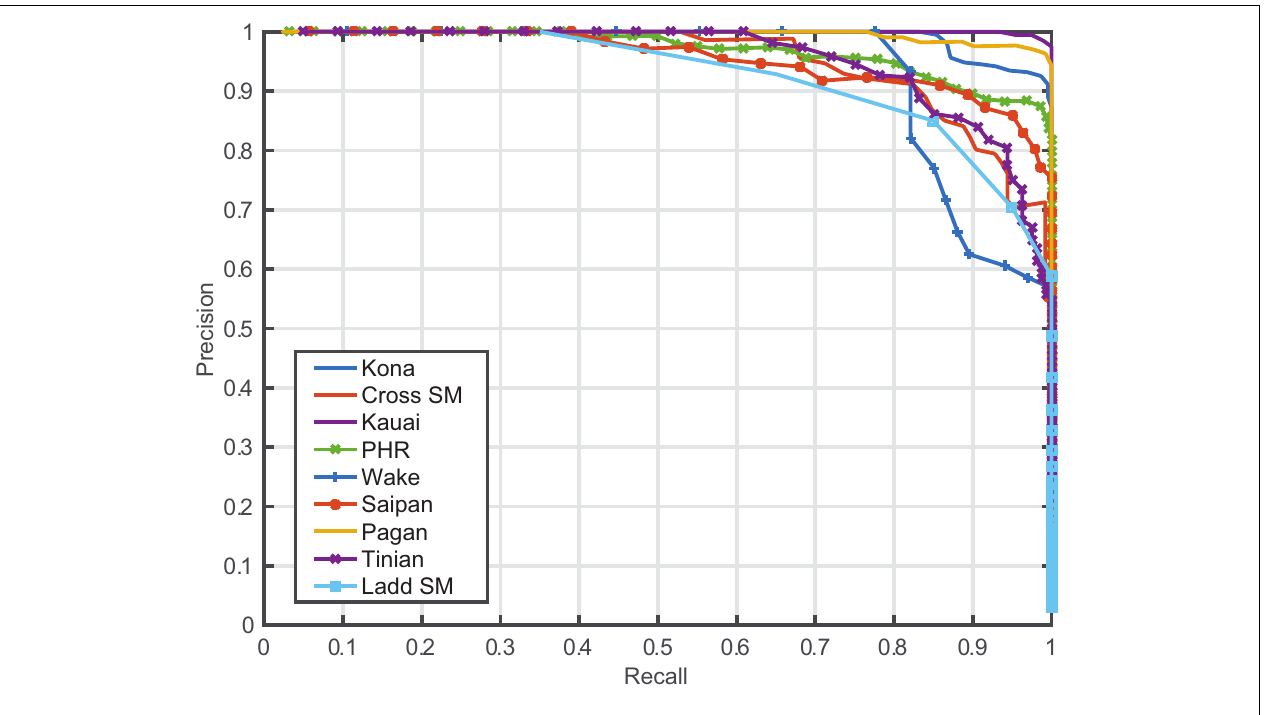
FIGURE 2 | Precision/recall curves for each site with humpback song.